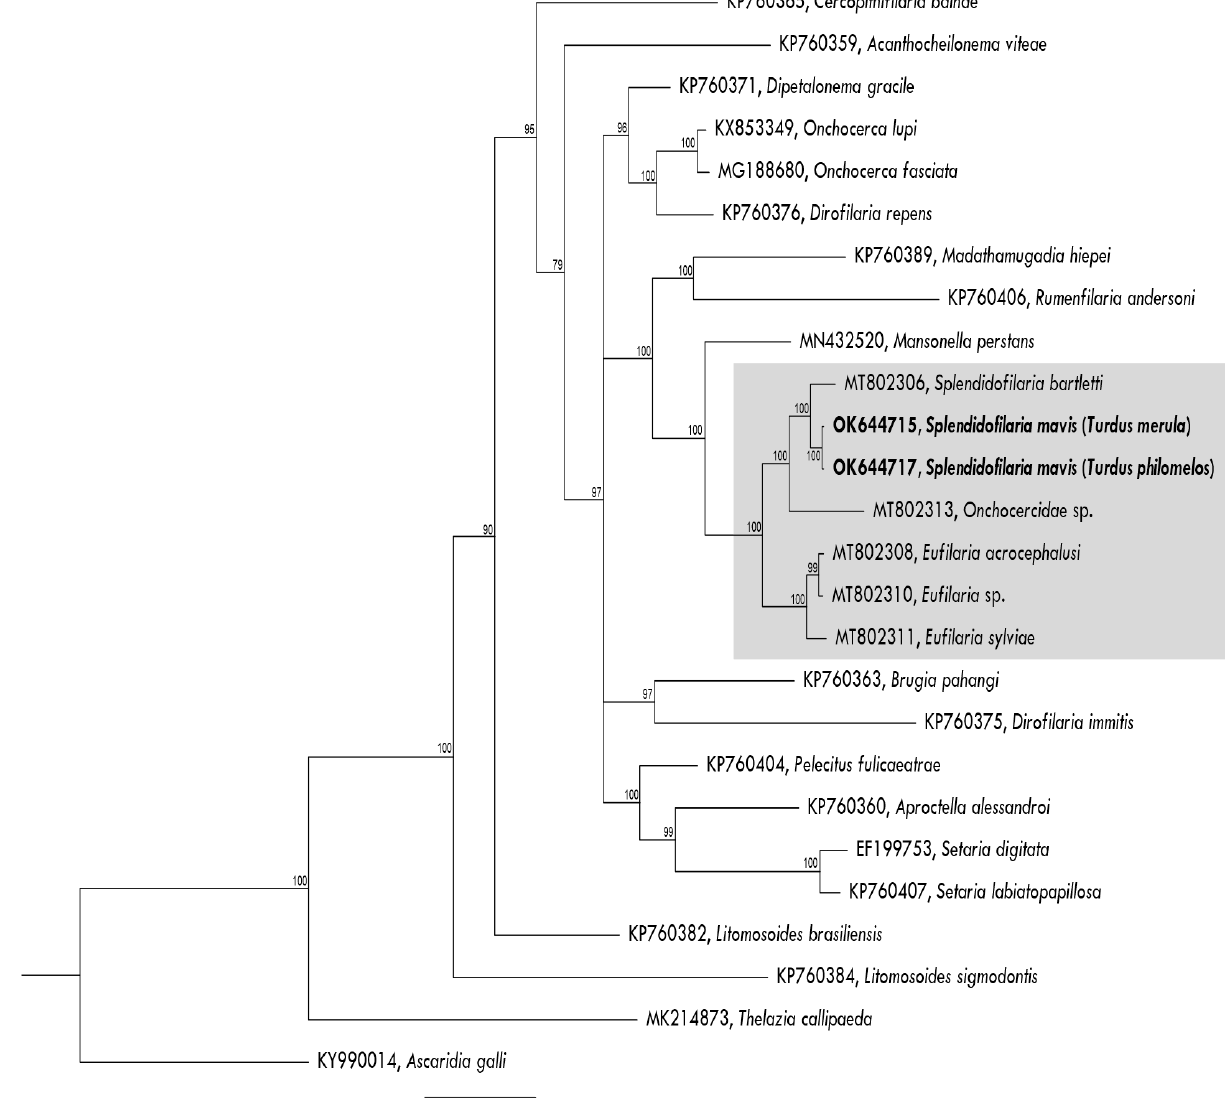
Figure 5. Bayesian phylogenetic inference tree based on partial 28S nuclear gene sequences of Splendidofilaria mavis and other closely related filarioid nematodes. The tree was rooted with Ascaria galli DNA sequence. Splendidofilaria mavis found in a Eurasian blackbird ( Turdus merula ) and a Song thrush ( Turdus philomelos ) and Splendidofilaria bartletti clustered together in a well-supported clade (grey box). Sequences that were obtained in this study are given in bold. The GenBank accession numbers are provided. Nodal support values indicate Bayesian posterior probability. Table 4. Measurements of adult Splendidofilaria mavis from the Eurasian blackbird ( Turdus merula ) and the Song thrush ( Turdus philomelos ) that were examined in this study. All measurements are given in micrometres, except for body length, which is given in millimetres.